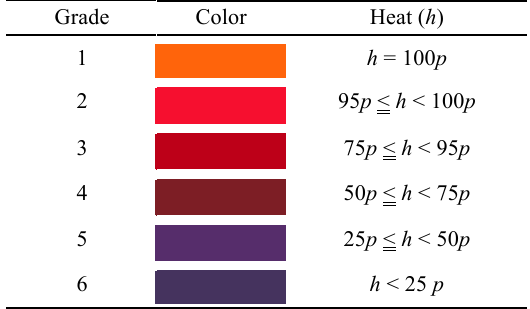
Heat grade and color assignment